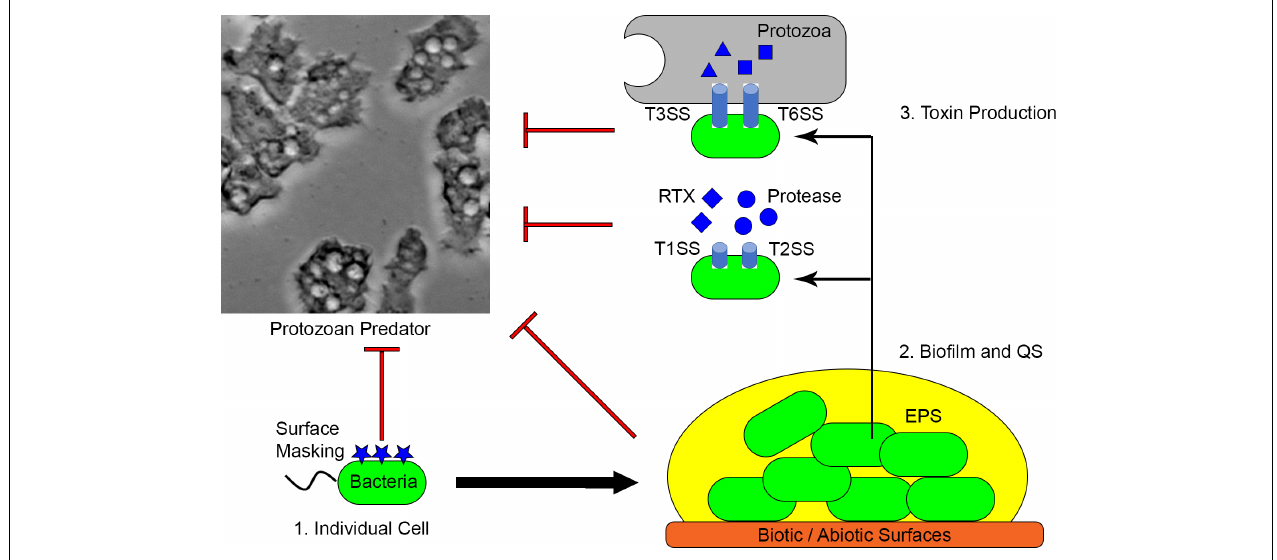
FIGURE 2 | Mechanisms utilized by extracellular pathogens. (1) Surface masking facilitates bacterial cells avoiding phagocytosis. (2) Extracellular pathogens form biofilms on various surfaces. EPS production and QS-regulated activities protect bacteria from predation. (3) Toxins produced by the biofilm community are important for both grazing resistance and animal